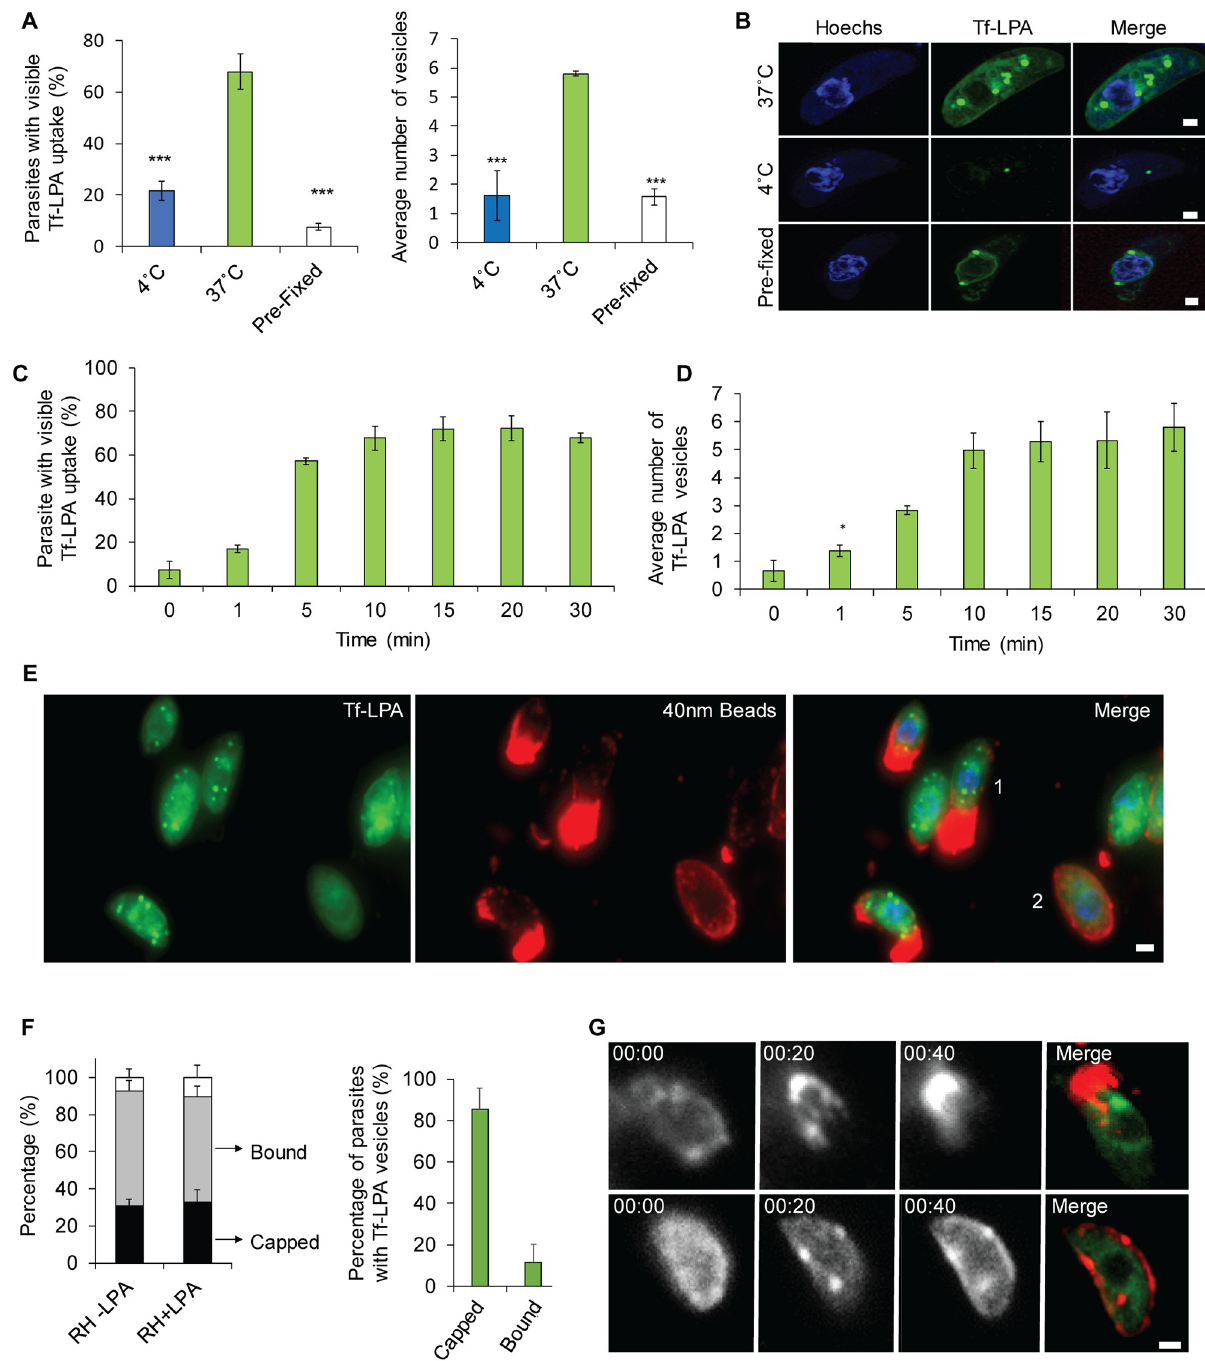
Fig 2. A link between retrograde flow and phospholipid uptake. (A-B) Uptake of phospholipids: Tf-LPA was analysed at 37 ˚C and 4 ˚C. Pre-fixed parasites with PFA were also incubated with Tf-LPA at 37 ˚C. Incubation at 37 ˚C demonstrates a strong uptake with vesicle formation. Uptake is inhibited at 4 ˚C or when the parasites were fixed prior to incubation. (A) Left panel: percentage of Tf-LPA–positive parasites in each of the tested conditions. Right panel: average number of Tf-LPA–positive vesicles per parasite in each of the tested conditions. Mean values of three independent assays are shown ± SD. ��� p < 0.001 obtained in a two-tailed Student t test when comparing Tf-LPA at 37 ˚C versus 4 ˚C and live parasites plus Tf-LPA versus fixed parasites plus Tf-LPA at 37 ˚C. (B) Example images obtained for the quantification as shown in (A). Scale bar, 1 μ m. (C-D) Dynamics of uptake were analysed in a time point assay from 0 to 30 minutes after addition of Tf-LPA. (C) Average number of parasites that show overall uptake and (D) average number of vesicles per positive parasite were determined. Mean values of three independent assays are shown ± SD. (E-G) Association of retrograde flow and endocytosis was analysing by adding Tf-LPA during the bead translocation experiment. (E) Representative picture of capping and